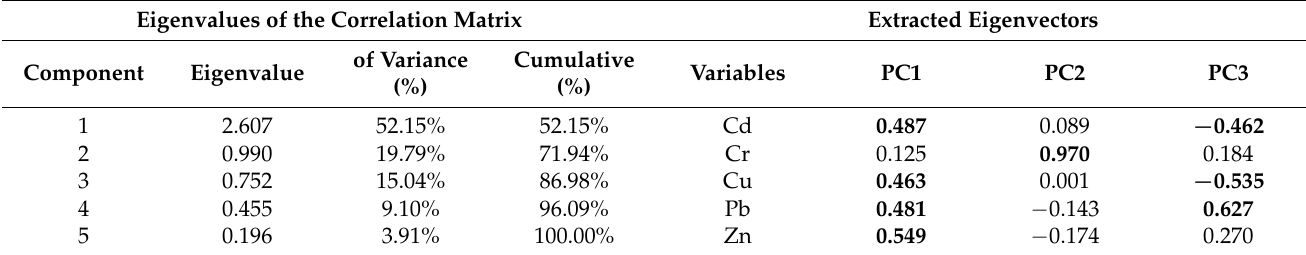
Table 3. Principal component analysis for Cd. Cr. Cu. Pb and Zn in the sediments from the Xiangjiang River basin ( n = 149). Eigenvalues of the Correlation Matrix Extracted